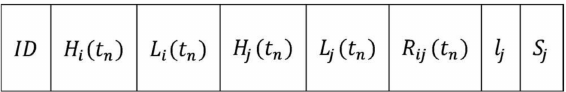
Figure 2. MKTS message table